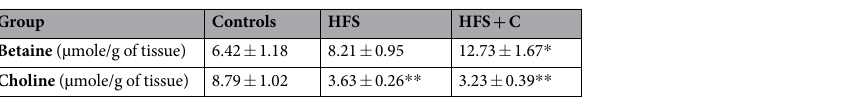
Table 2. Betaine and choline concentrations in liver samples. Values are mean ± S.E.M (n = 6–12 rats/group). * P < 0.05 vs. the control and the HFS group, ** P < 0.01 vs. the